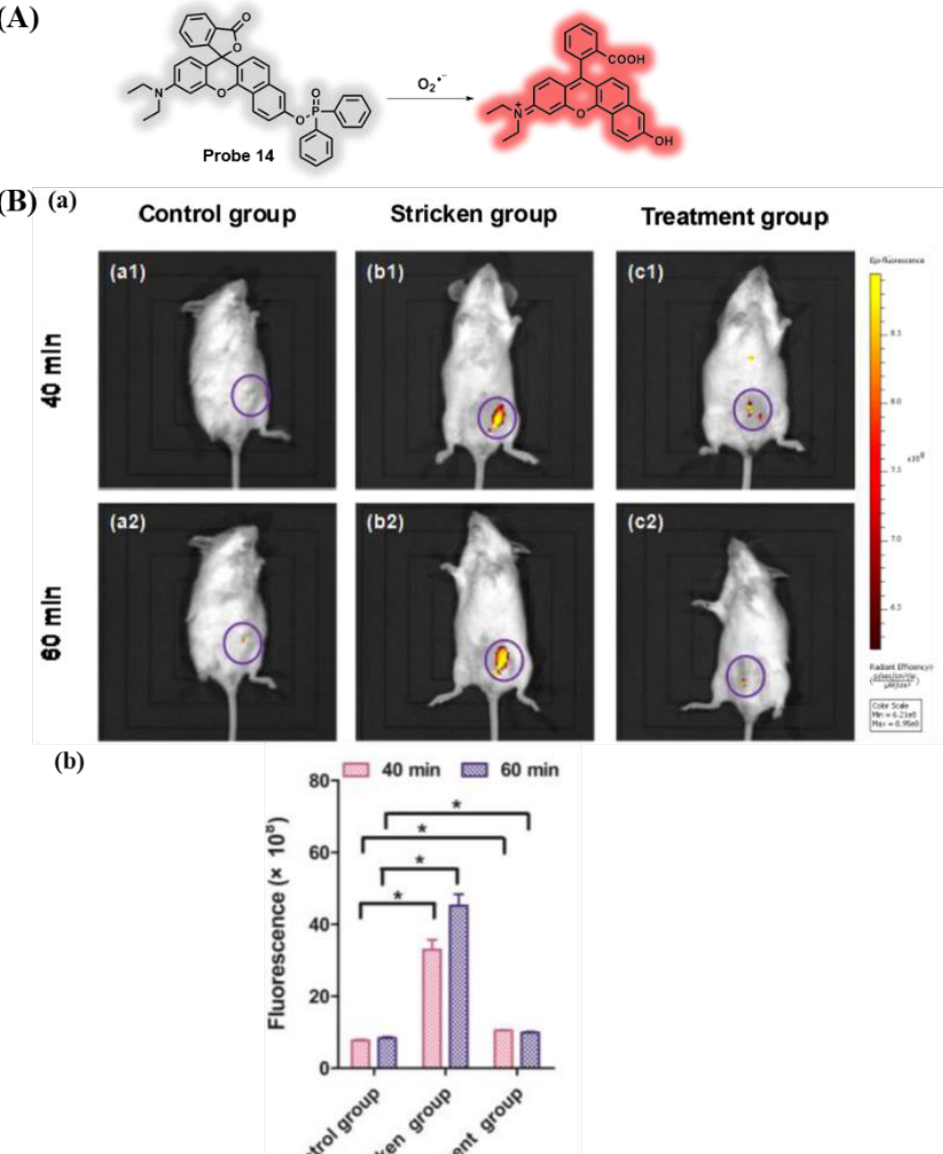
Figure 12. ( A ) Imaging mechanism of probe 14 ; ( B - a ) imaging experiments after injecting 40 μL probe 14 (1 mM in DMSO) into the abdominal cavity of mice at 40 and 60 min, respectively, λ ex / em = 580/620 nm; ( B - b ) changes in the fluorescence intensity in the purple circle from ( B ). Statistical anal- yses were performed with a Student’s t -test. * p < 0.01, (n = 3). Adapted from Reference [85]. Copy- right 2021, Elsevier B.V.